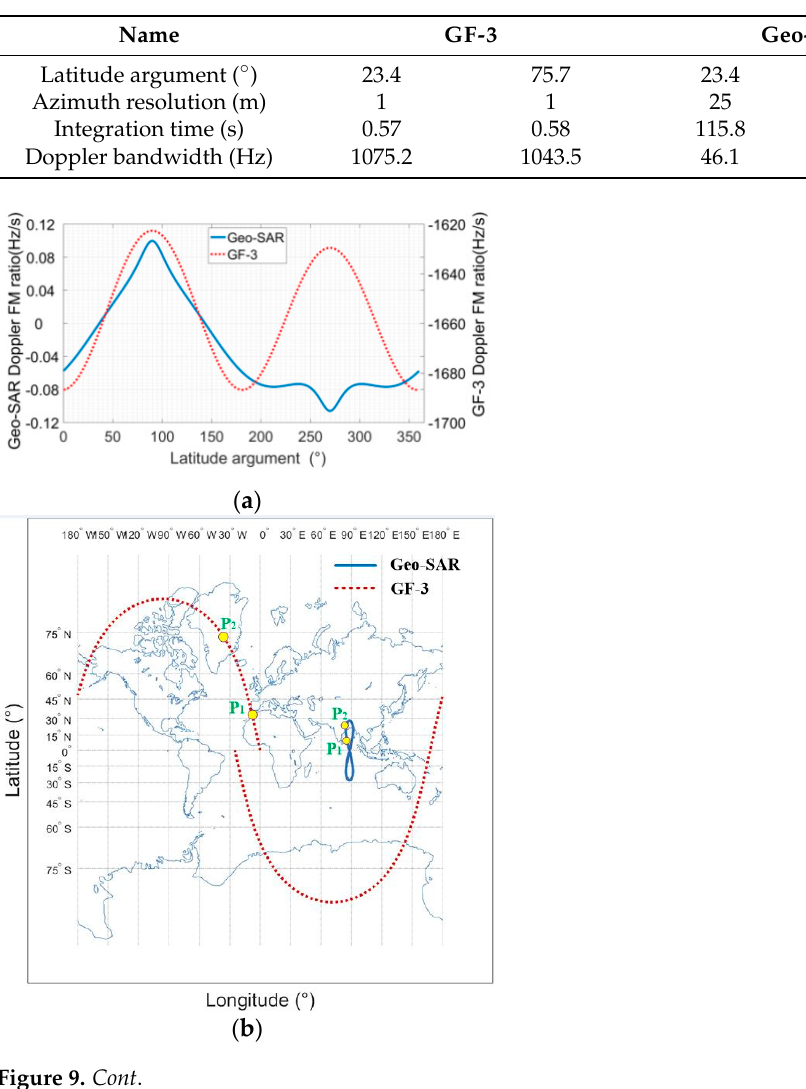
( f ) Figure 9. Staring mode Doppler history characteristics comparison between Geo-SAR and GF-3. ( a ) Doppler FM rate comparison between GF-3 and Geo-SAR. ( b ) P1(23.4°) and P2(75.7°) in nadir trace, and their positions comparison between GF-3 and Geo-SAR. ( c ) Doppler history, P1, GF-3. ( d ) Doppler history, P2, GF-3. ( e ) Doppler history, P1, Geo-SAR. ( f ) Doppler history, P2, Geo-SAR. Table 2. Doppler history comparison between GF-3 and Geo-SAR. Name GF-3 Geo-SAR